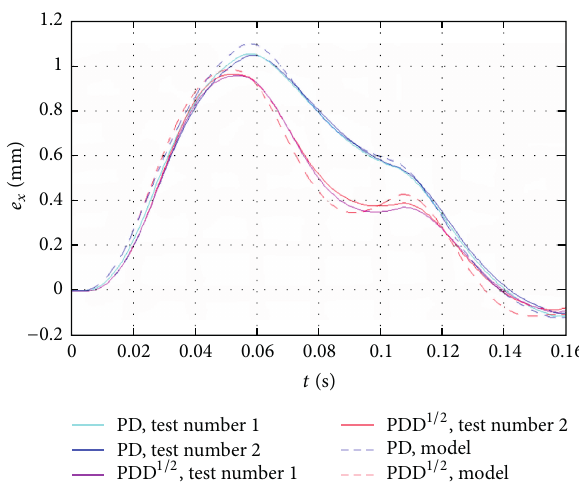
Figure 15: PD-PDD 1/2 comparison: tracking error in case of set point with trapezoidal speed law (PD: 𝜁 = 0.8 ; PDD 1/2 : 𝜁 = 0.46, 𝜓 = 0.7990